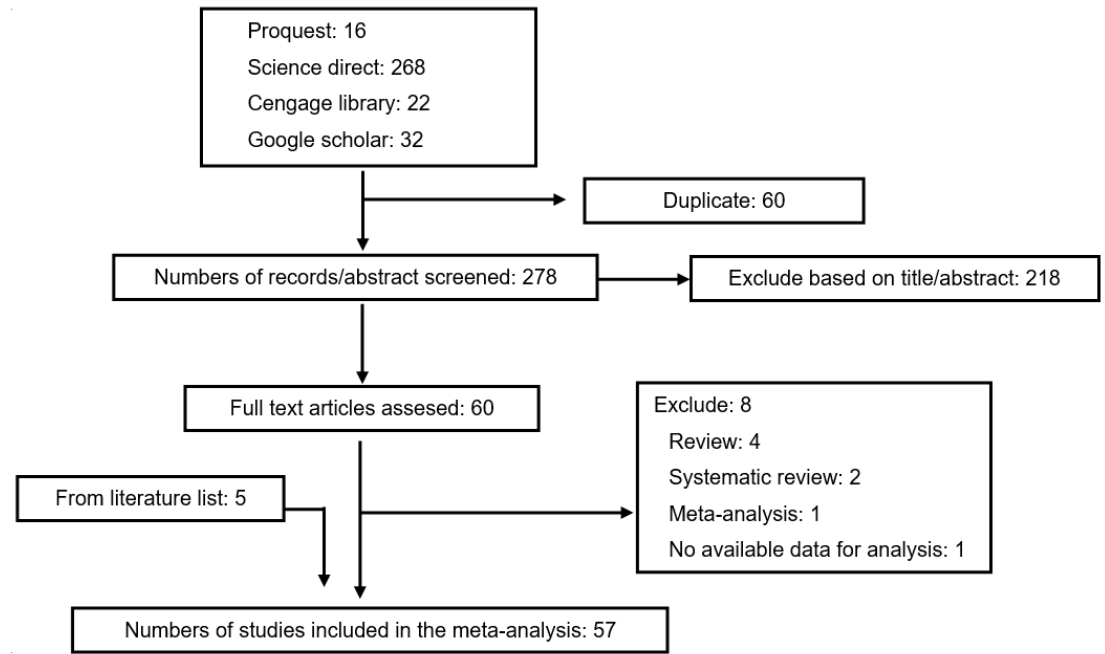
Figure 1. The preferred reporting items for systematic reviews and meta-analyses (PRISMA) flow chart of the literature review process.